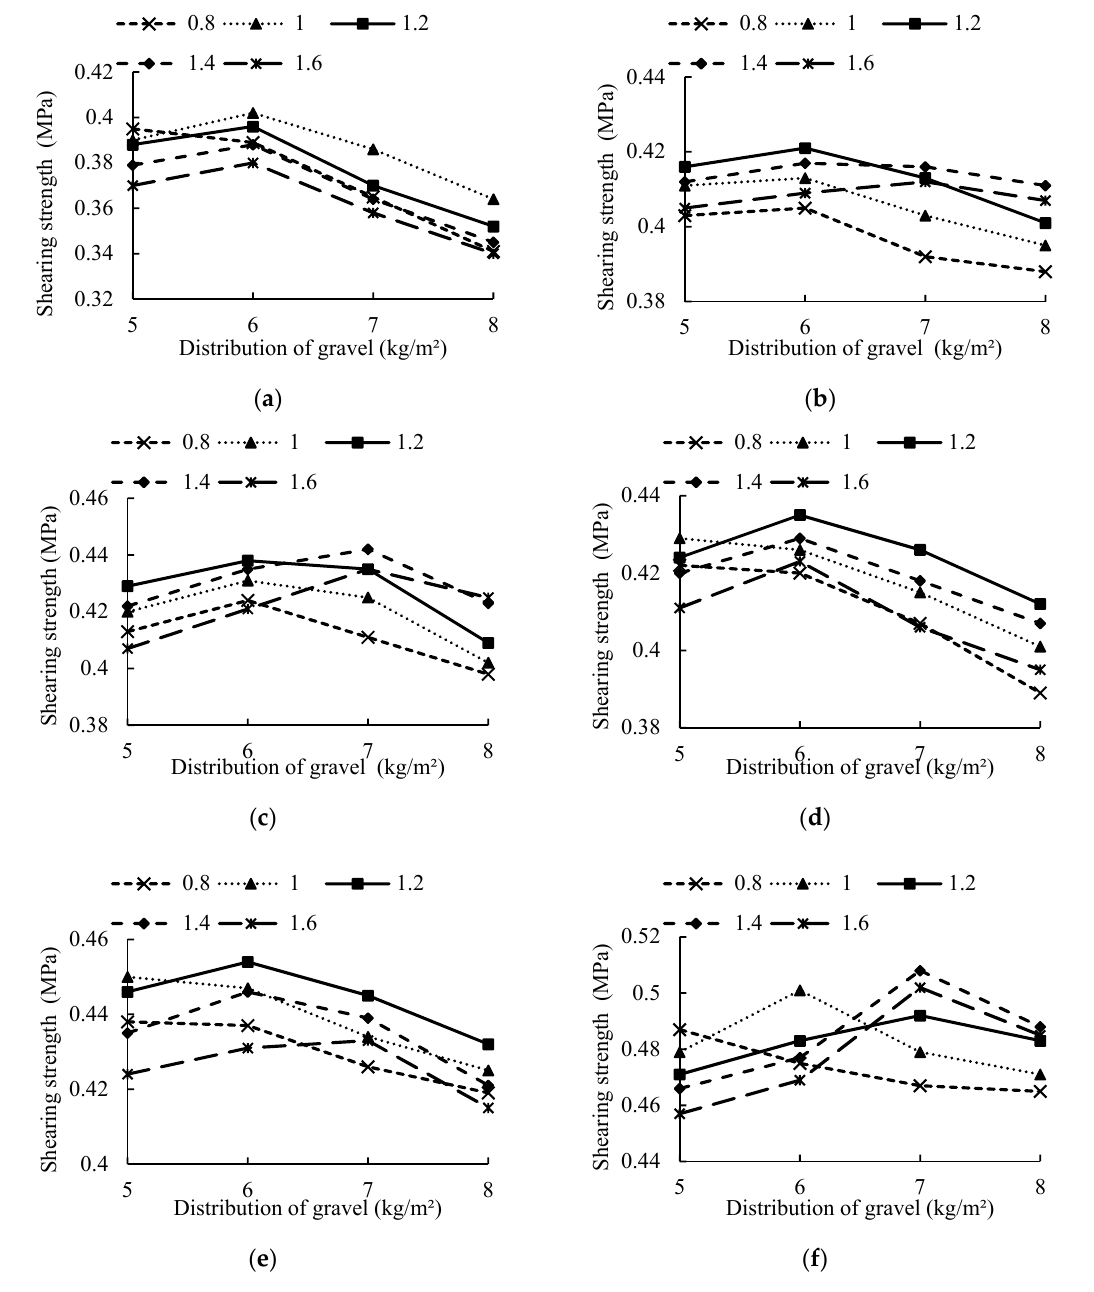
Figure 4. Shear strength of 90 ordinary hot asphalt with different spreading and disposal schemes: ( a ) Ord-A-brushed; ( b ) Ord-A-grooved; ( c ) Ord-A-exposed; ( d ) Ord-B-brushed; ( e ) Ord-B-grooved; ( f ) Ord-B-exposed.